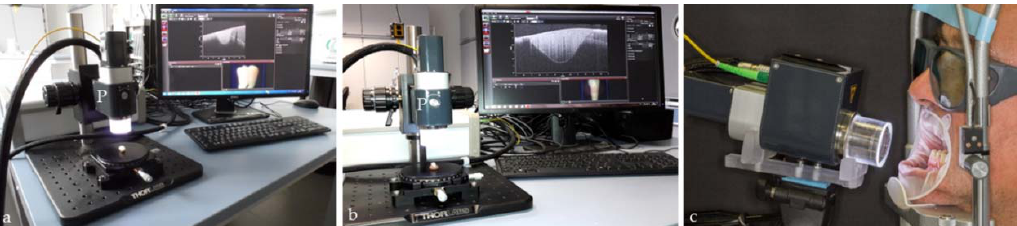
Figure 4. ( a ) SD ‐ OCT Telesto SP II; and ( b ) SSOCT OCS1300SS; ( c ) In vivo imaging of vestibular smooth surfaces of incisors, canines and premolars with the handheld and mechanically stabilized scanning probe (P).